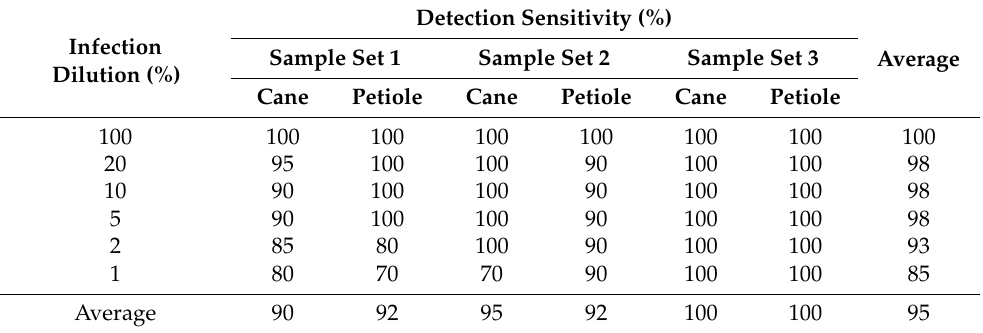
Table 4. Sensitivity for dilutions of three virus-infected grapevine sample sets comprised of two tissue types extracted in